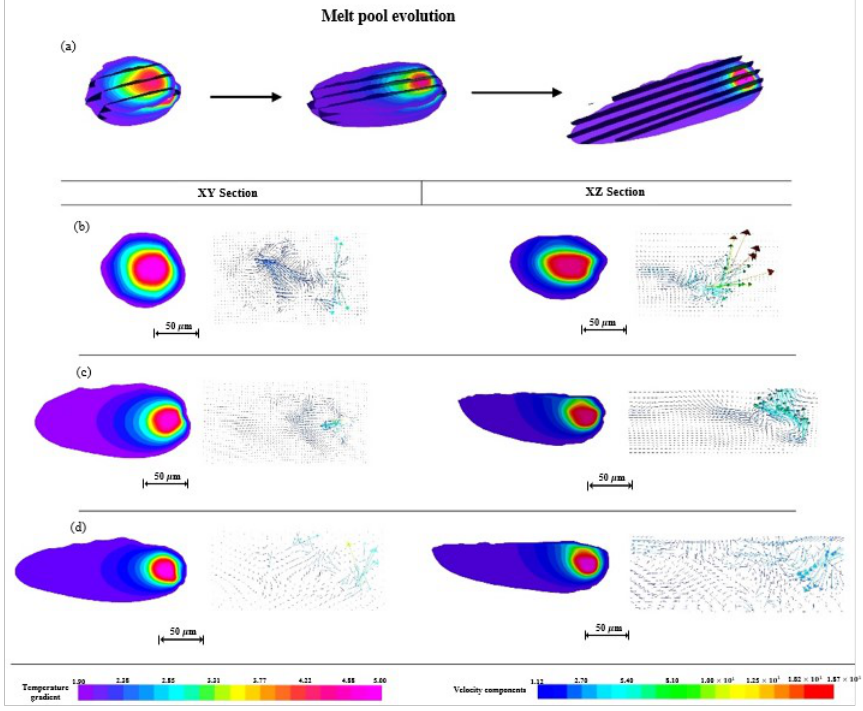
Figure 15. Evolution of the melt pool geometry ( a ); evolution of temperature gradient and fluid flow at initial ( b ), intermediate, ( c ) and end ( d ) position of the second track scanning in XY and XZ sections, respectively.